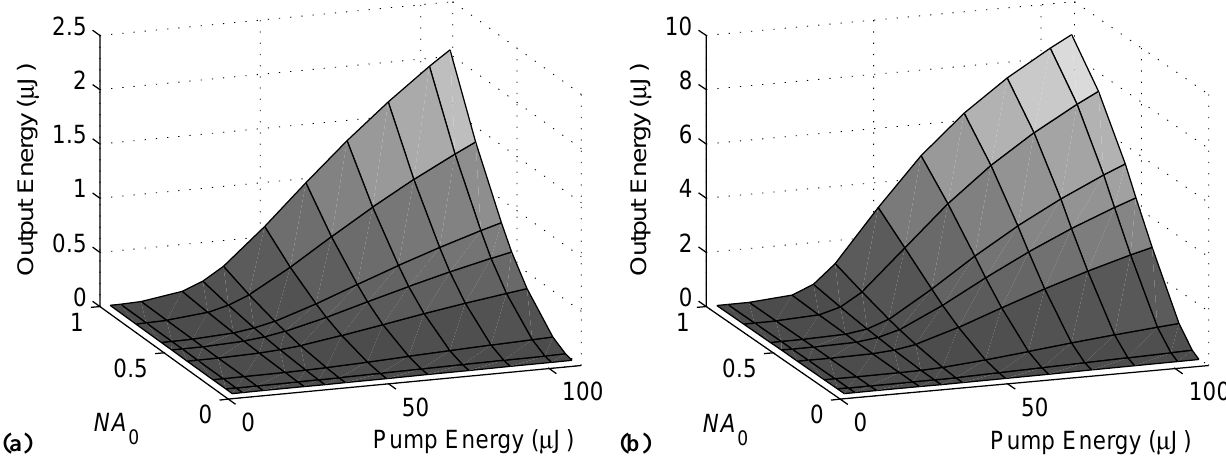
Figure 7. Evolution of the output energy at 581 nm for different values of the numerical aperture when the fiber is pumped with several pump energies: ( a ) SI; and ( b ) GI POFs with γ = 1.43. Parameters as in Table 2.